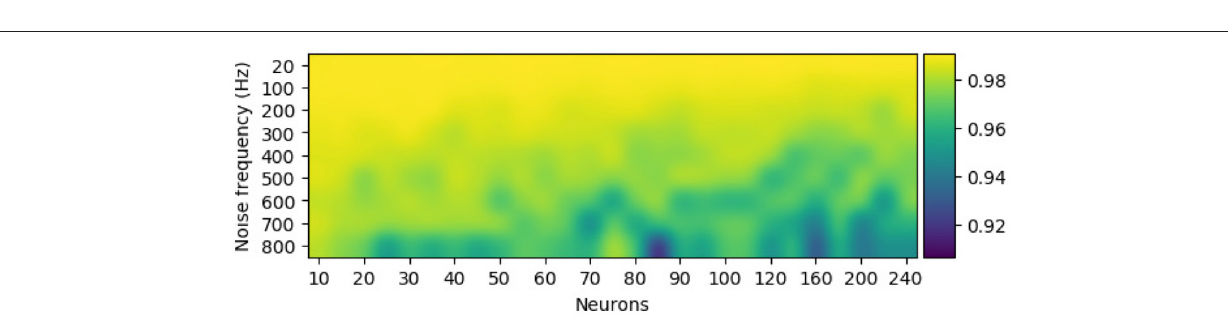
descent approach (Zenke and Ganguli, 2018; Neftci et al.,